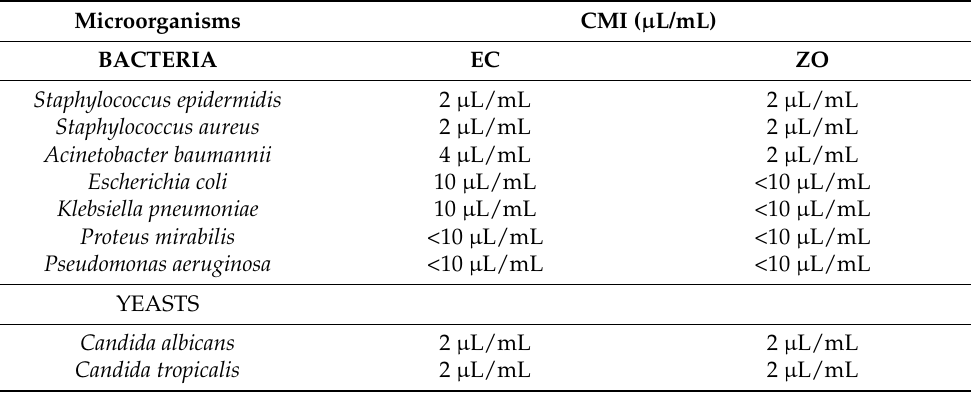
Table 4. Minimal inhibitory concentration of the essential oil of Zingiber officinale Roscoe and Elettaria cardamomum (L.) Maton.